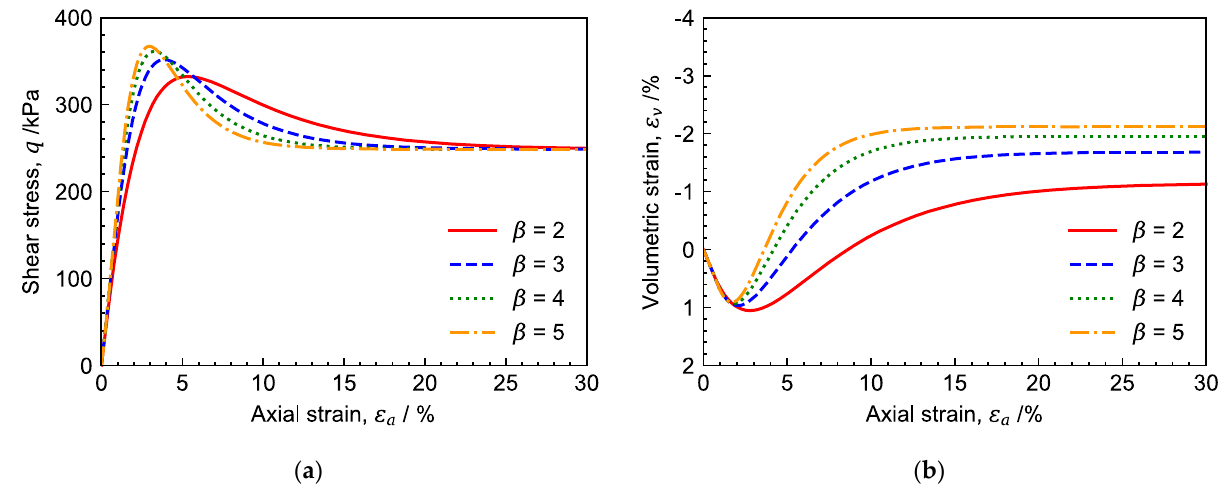
Figure 5. The performance of the proposed stress–dilatancy relation and the yield function: ( a ) the stress–axial strain relation; ( b ) the volumetric strain–axial strain relation.